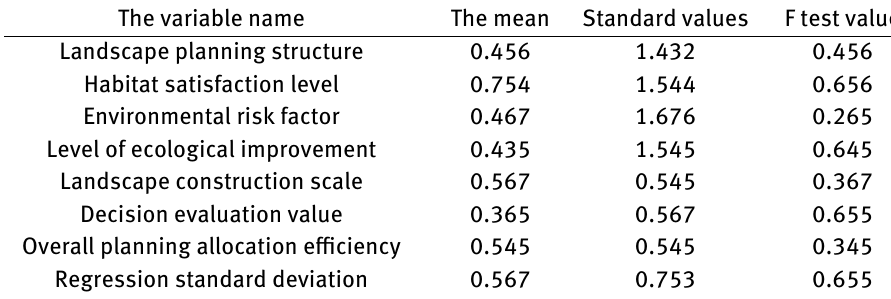
Table 2: Regression analysis values and test